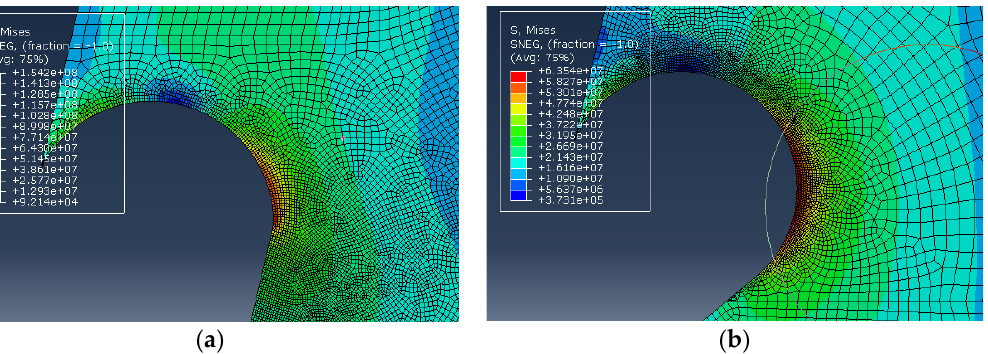
Figure 6. Stress cloud diagram before and after optimization of arc-shaped incision: ( a ) Before reinforcement, ( b ) after optimization of short crack arc cut.